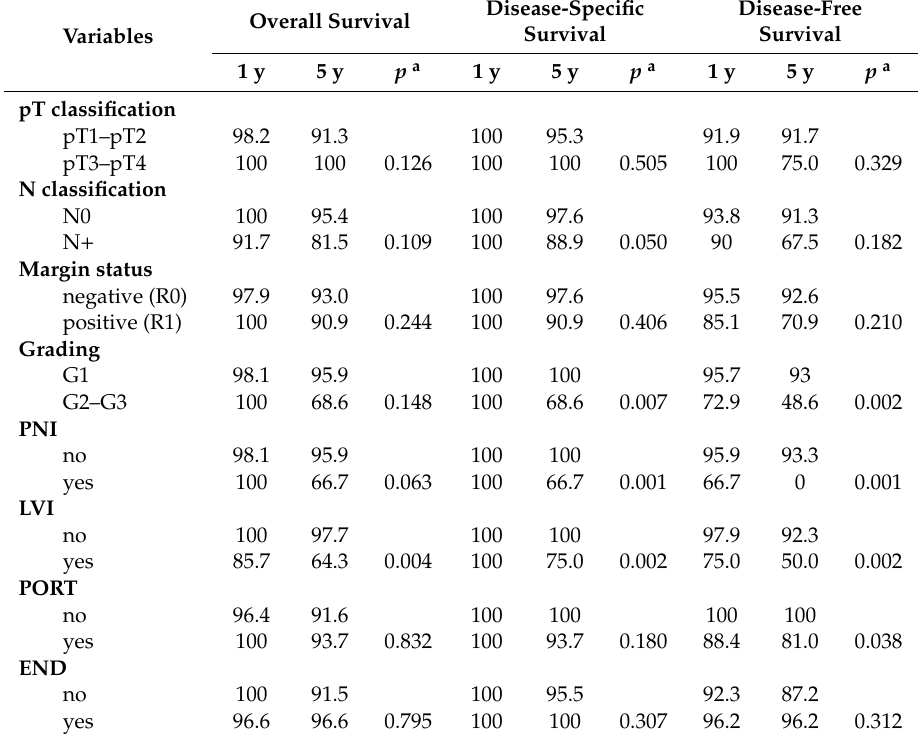
Table 4. Kaplan–Meier survival analyses.